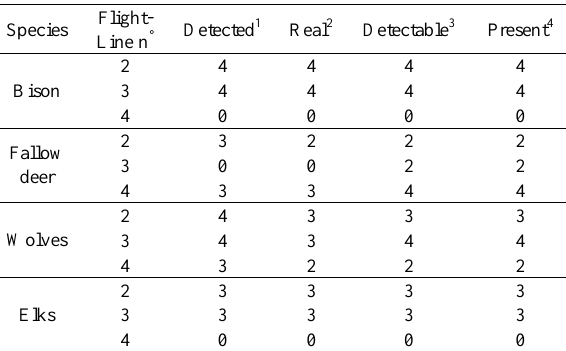
Table 3. Classification results for each flight line using